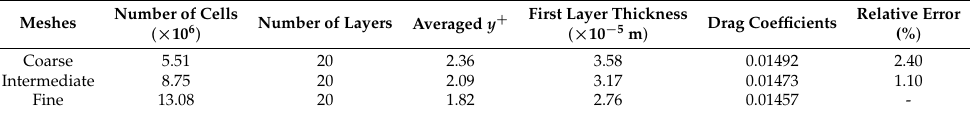
Table 1. Results of the grid sensitivity test. The “relative error” in the last column presents the percentage of the drag coefficient difference that the corresponding mesh has compared with the fine mesh.